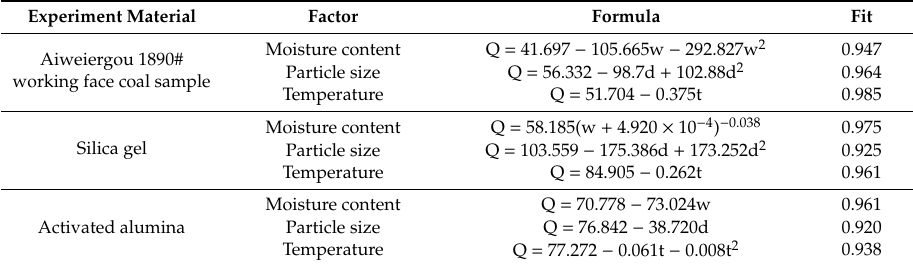
Table 2. Fitting relationship between adsorption and every